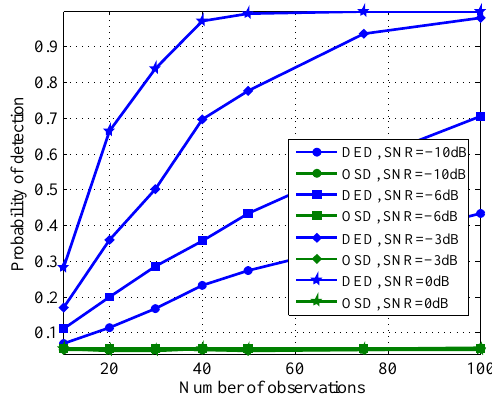
Figure 5. Probability of detection: DED and OSD vs. M for different SNRs | Gaussian primary signal | Rayleigh fading: Parameter = 1 .